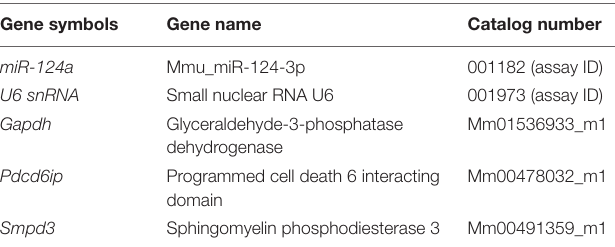
TABLE 1 | TaqMan hydrolysis probes (Thermo Fisher Scientific, MA, United States) used for qPCR. Gene